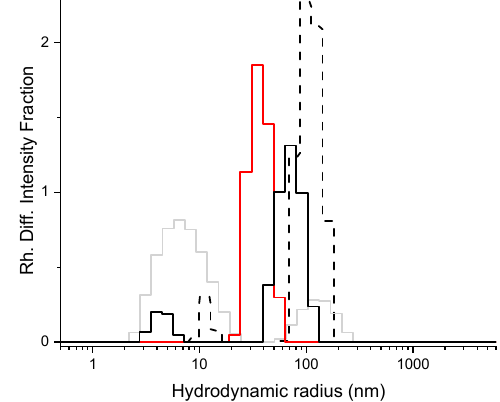
Figure 6. Dynamic Light Scattering (DLS) measurements of GO (black dashed line), PVA (grey line), PVA@GO (black line), and PVA@rGO-Ag1 (red line) in water (samples concentration 12.5 μ g/mL).